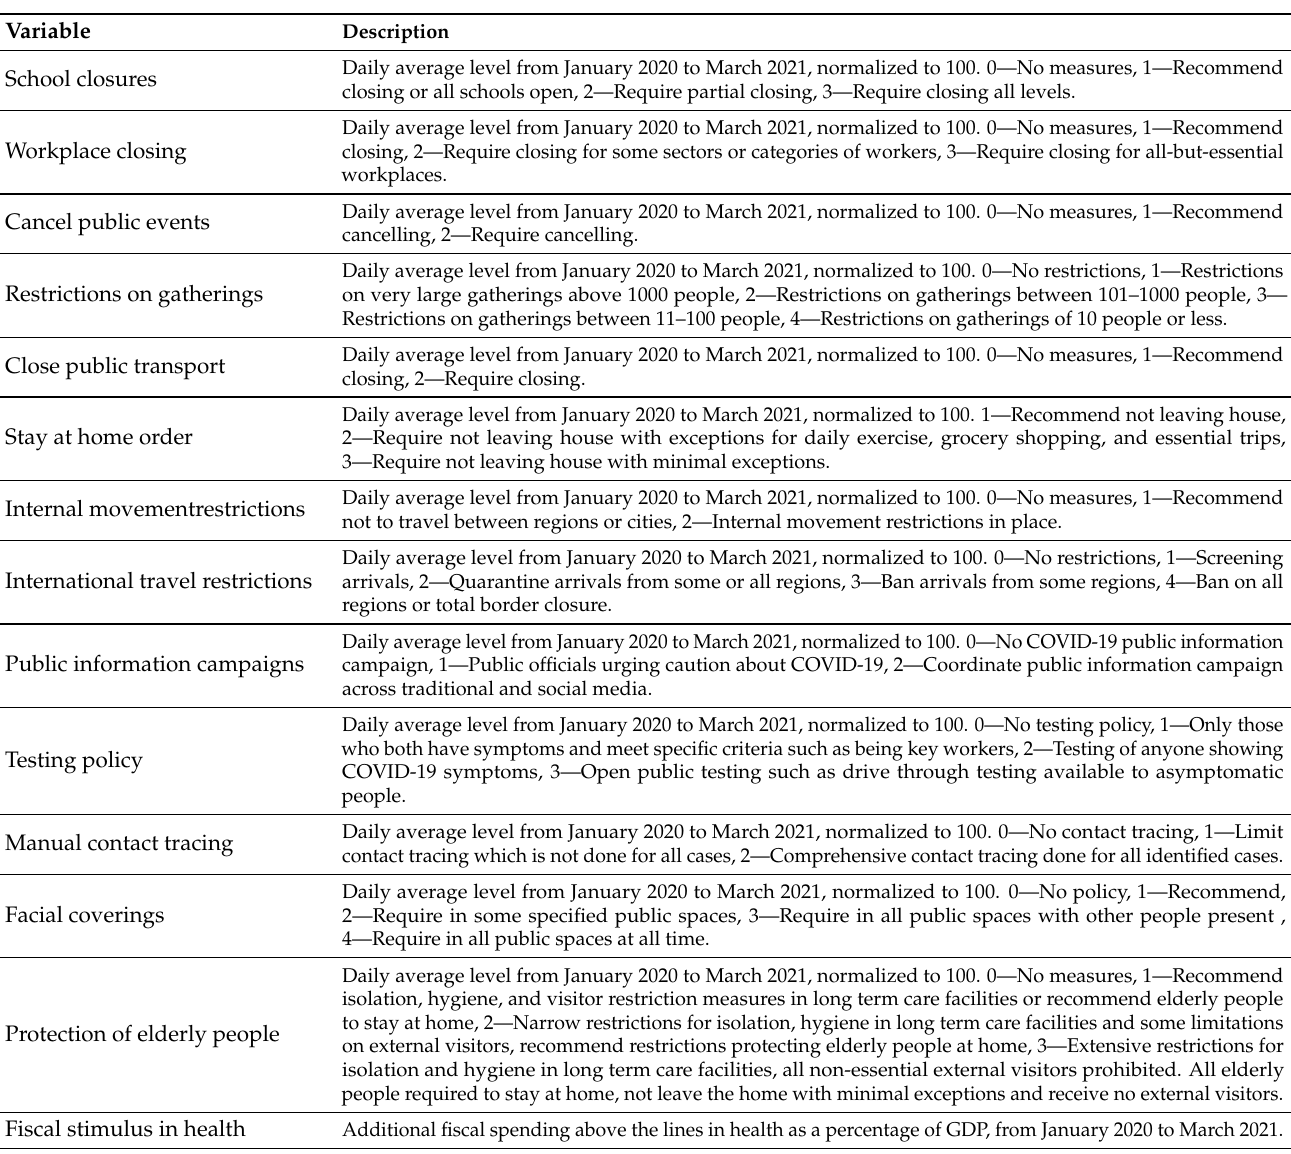
Table A2. Variable descriptions: policy